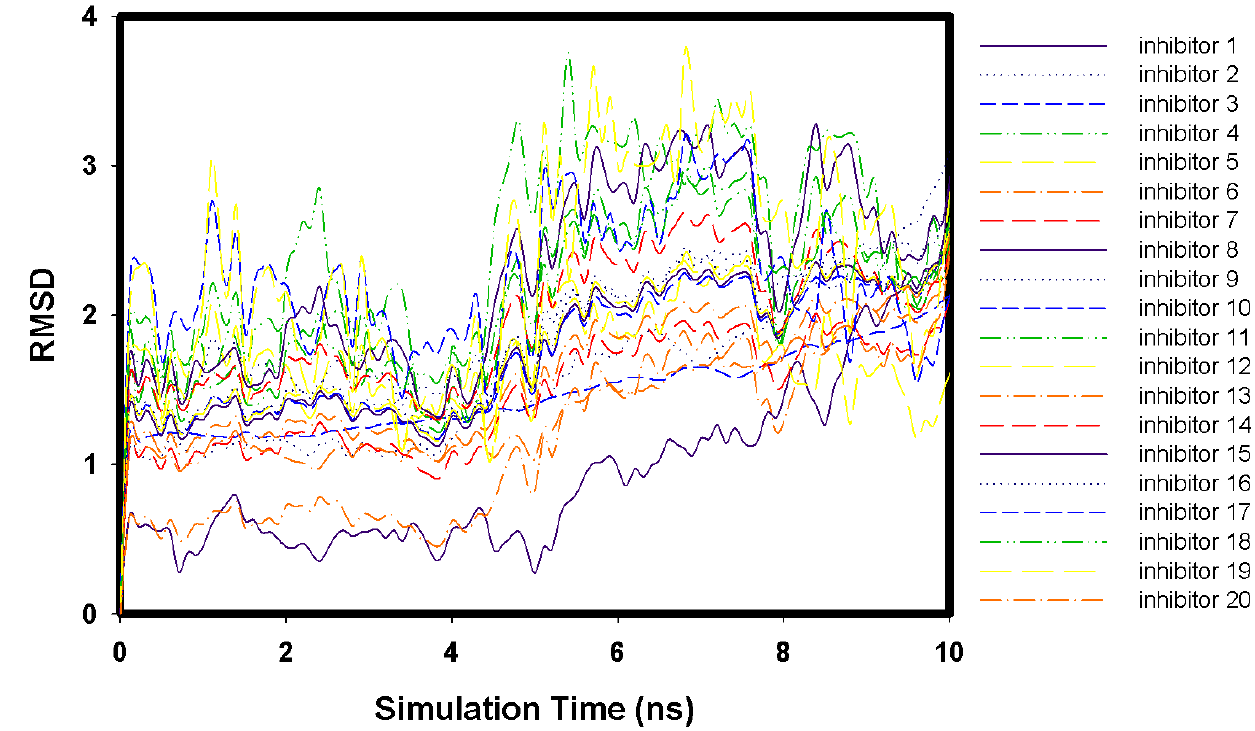
Figure 1. RMSD profiles of 20 flavonoid derivatives.